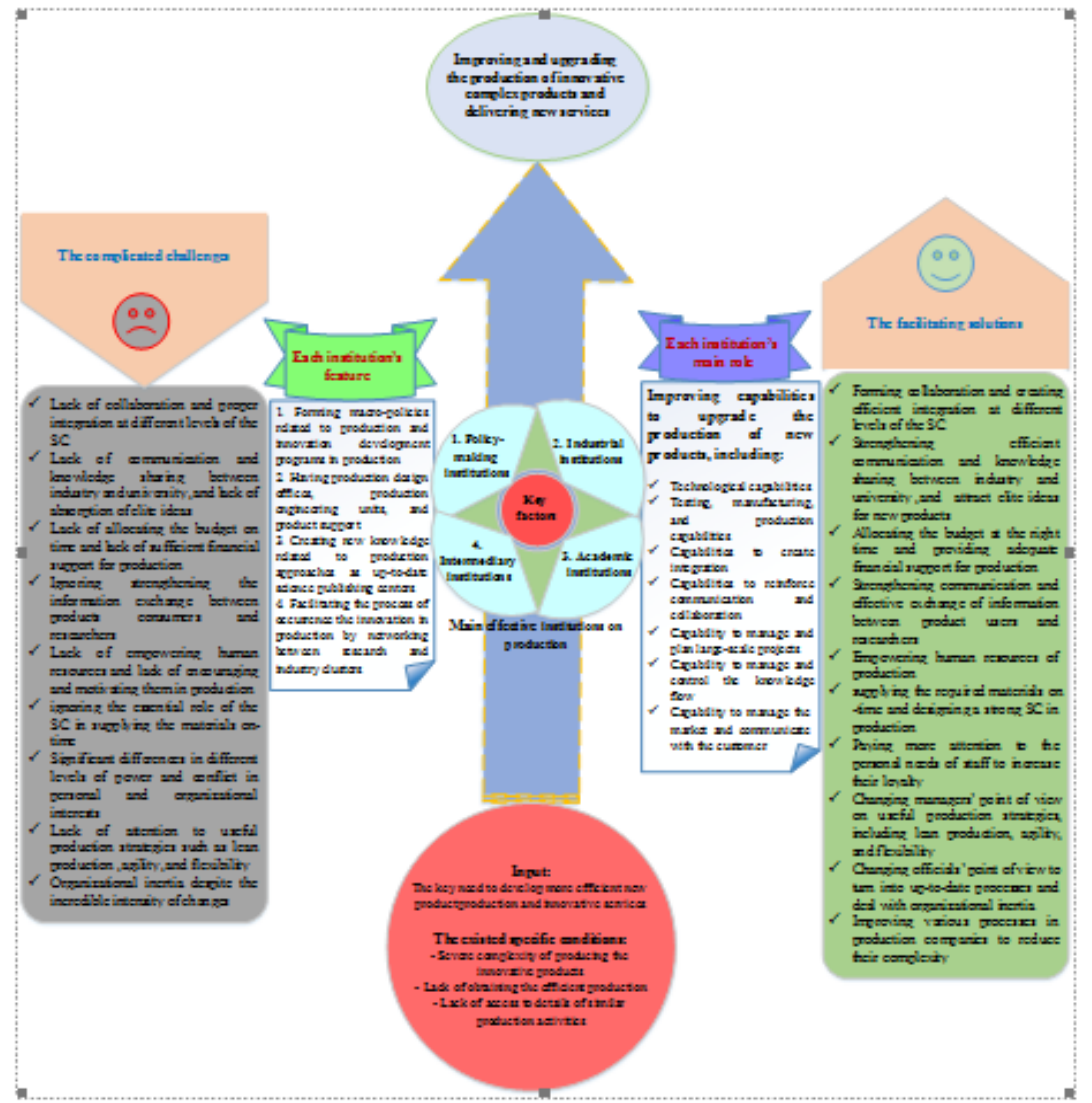
Fig. 4. The model of realizing and promoting the innovative production and services.